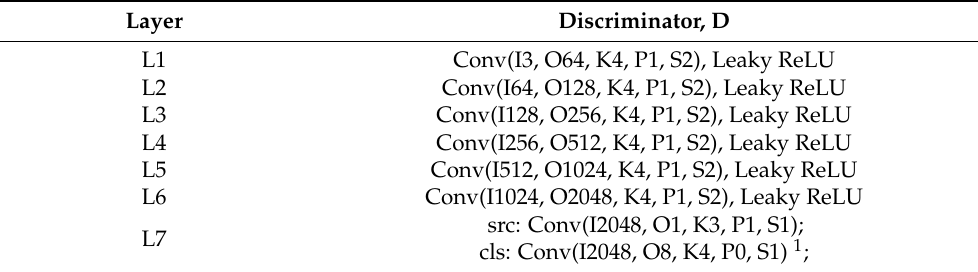
Table 2. Architecture of the discriminator.